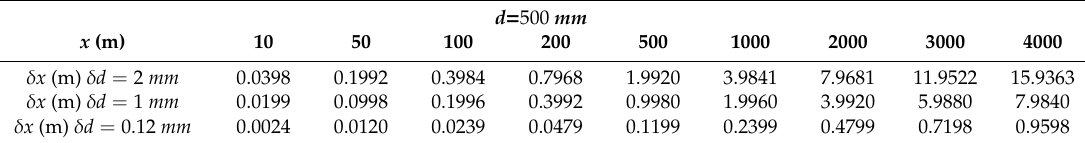
Table 4. Horizontal positioning error of the USBL caused by the spacing error of the array elements. ( d = 500 mm , x-axis